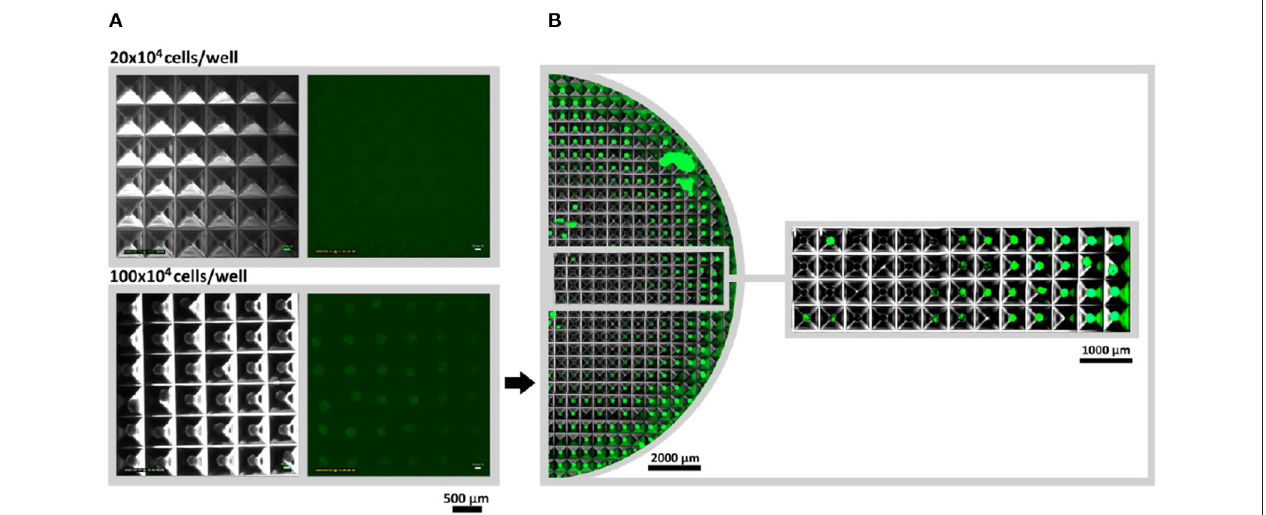
FIGURE 5 | Large scale spheroid formation in microstructured wells. (A) Spheroids were monitored via Lumascope for 20 × 10 4 and 100 × 10 4 cells per well after 24h of formation time. Larger spheroids (100 × 10 4 cells/multiwell) would express the hypoxia reporter protein UnaG, while low numbers (20 × 10 4 cells/multiwell) did not show a signal. For both studied seeded cell numbers images were taken from the outer corner of the well to guarantee comparability. (B) For 100 × 10 4 cell/multiwell half the well was accessed via image stitching. Time-laps video of spheroid formation and onset of fluorescence can be seen in Supplementary Video 3 .